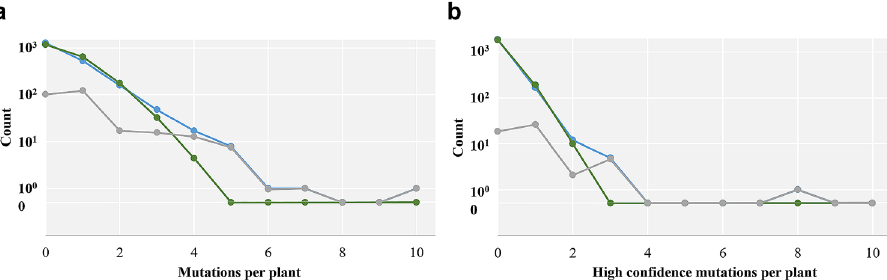
Figure 3. Comparison of Poisson modeling and observed polymorphism rates. The green line and points represent a typical outcome according to the Poisson distribution for 2048 individuals. In blue is the observed incidence. The grey line displays the absolute difference between modeled and observed. ( a) Mutations with F(t) > 2. ( b) Mutations with F(t) >